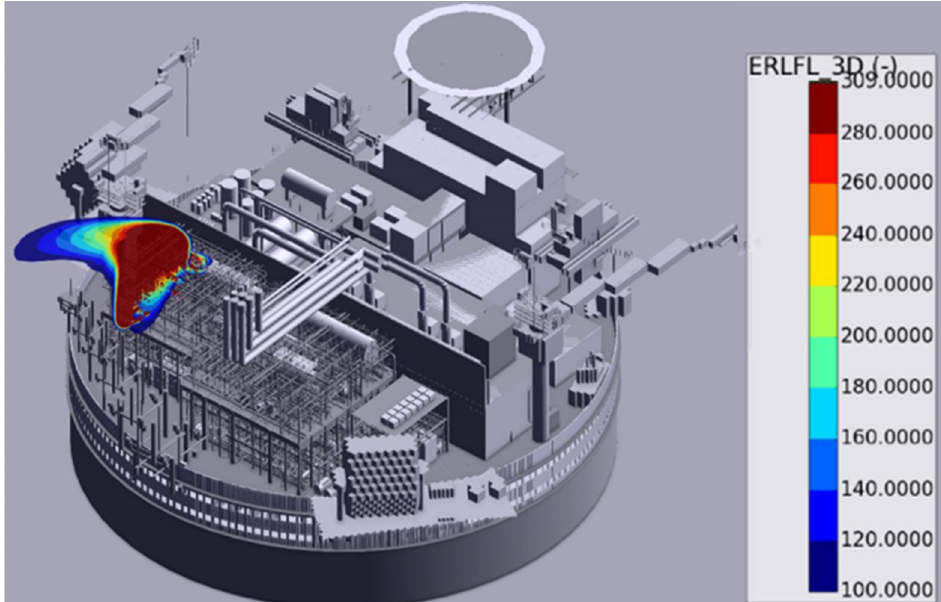
Figure 11. Gas cloud obtained for case 651,117. North leak direction, 25 kg/s leak rate, east wind direction, and 6 m/s wind speed.